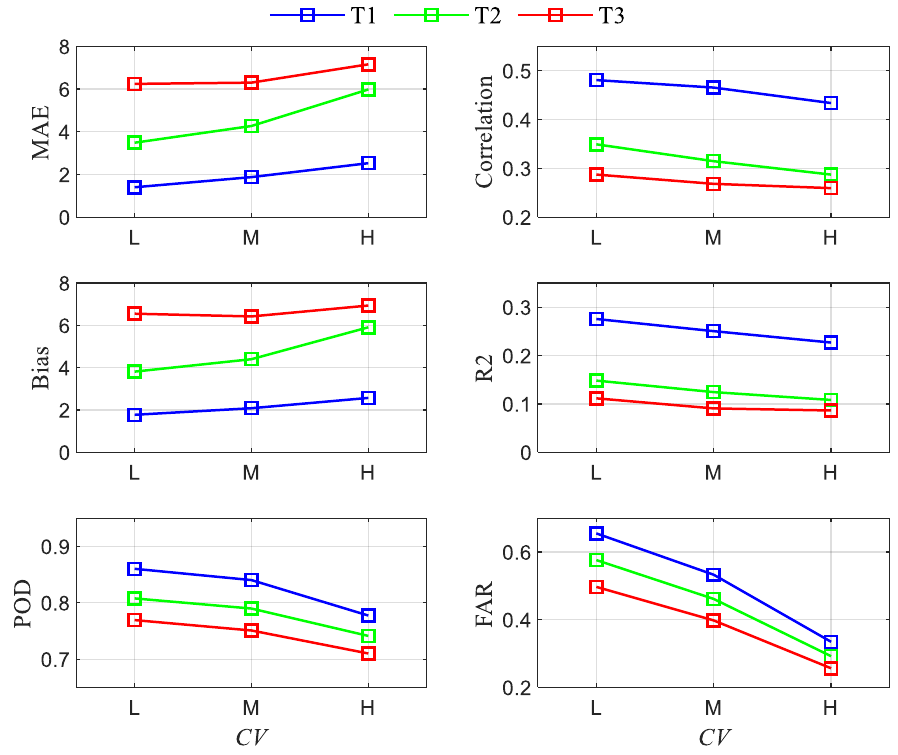
Figure 10. Comparison of rainfall nowcasting skills shown in Figure 6 under di ff erent lead times and rainfall spatial